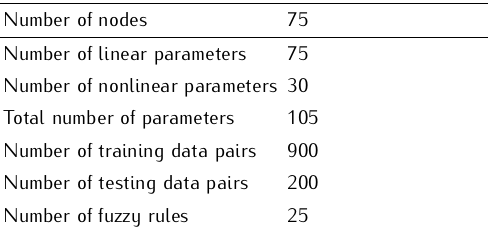
Table 2. ANFIS parameters.